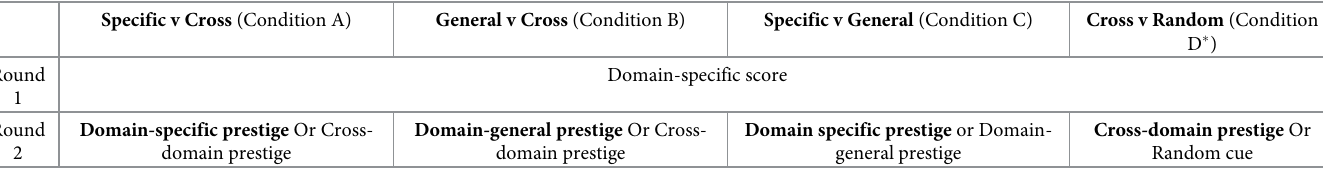
Table 1. Information displayed when choosing to “Ask Someone Else” in Rounds 1 and 2 across conditions, with our predicted choice for Round 2 in bold. Specific v Cross (Condition